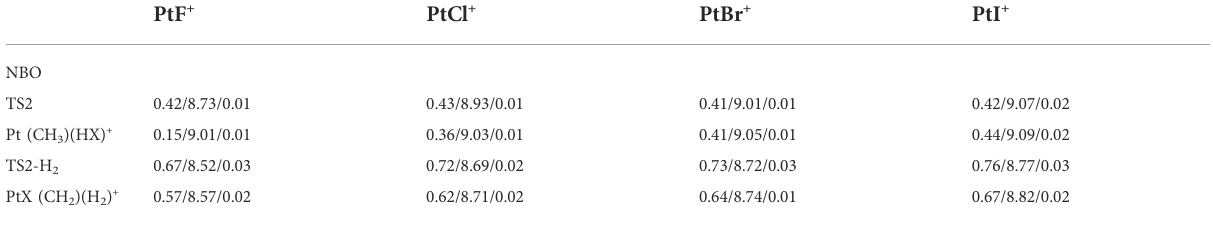
TABLE 3 Valence NBO populations for the 6s/5d/6p orbitals of Pt and the natural population analysis (NPA) charge of the related atoms in part of the key structures in the reaction of PtX + (X = F, Cl, Br, I) + CH 4 in the singlet